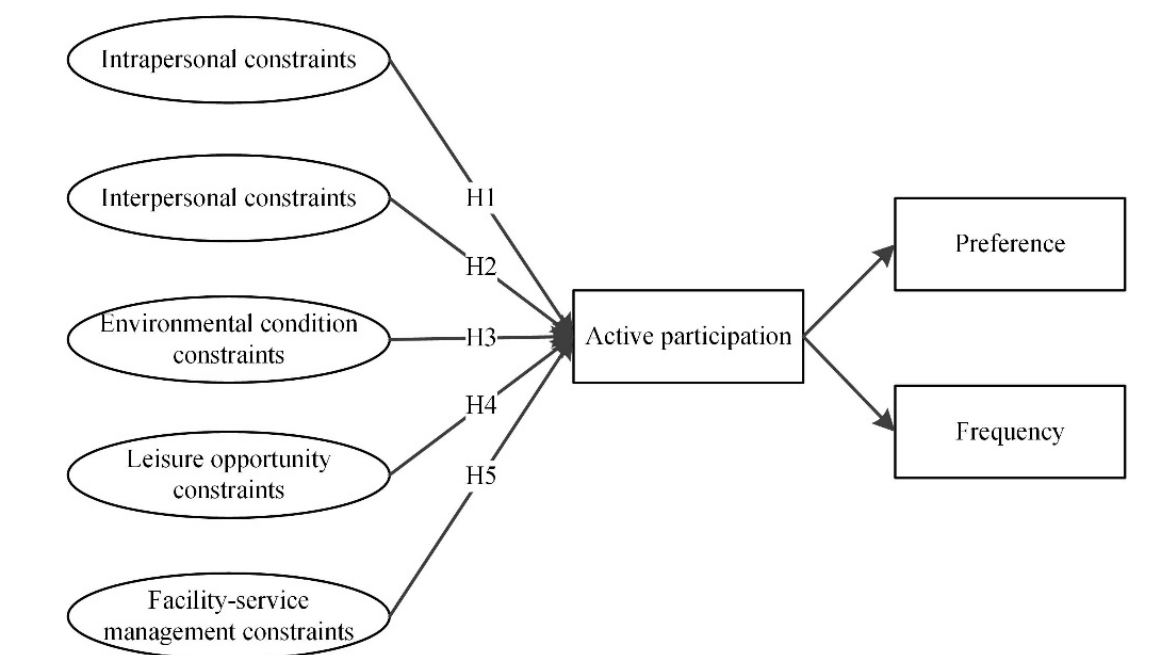
Figure 1. Hypothesized perceived constraints and the active recreational sport participation model.